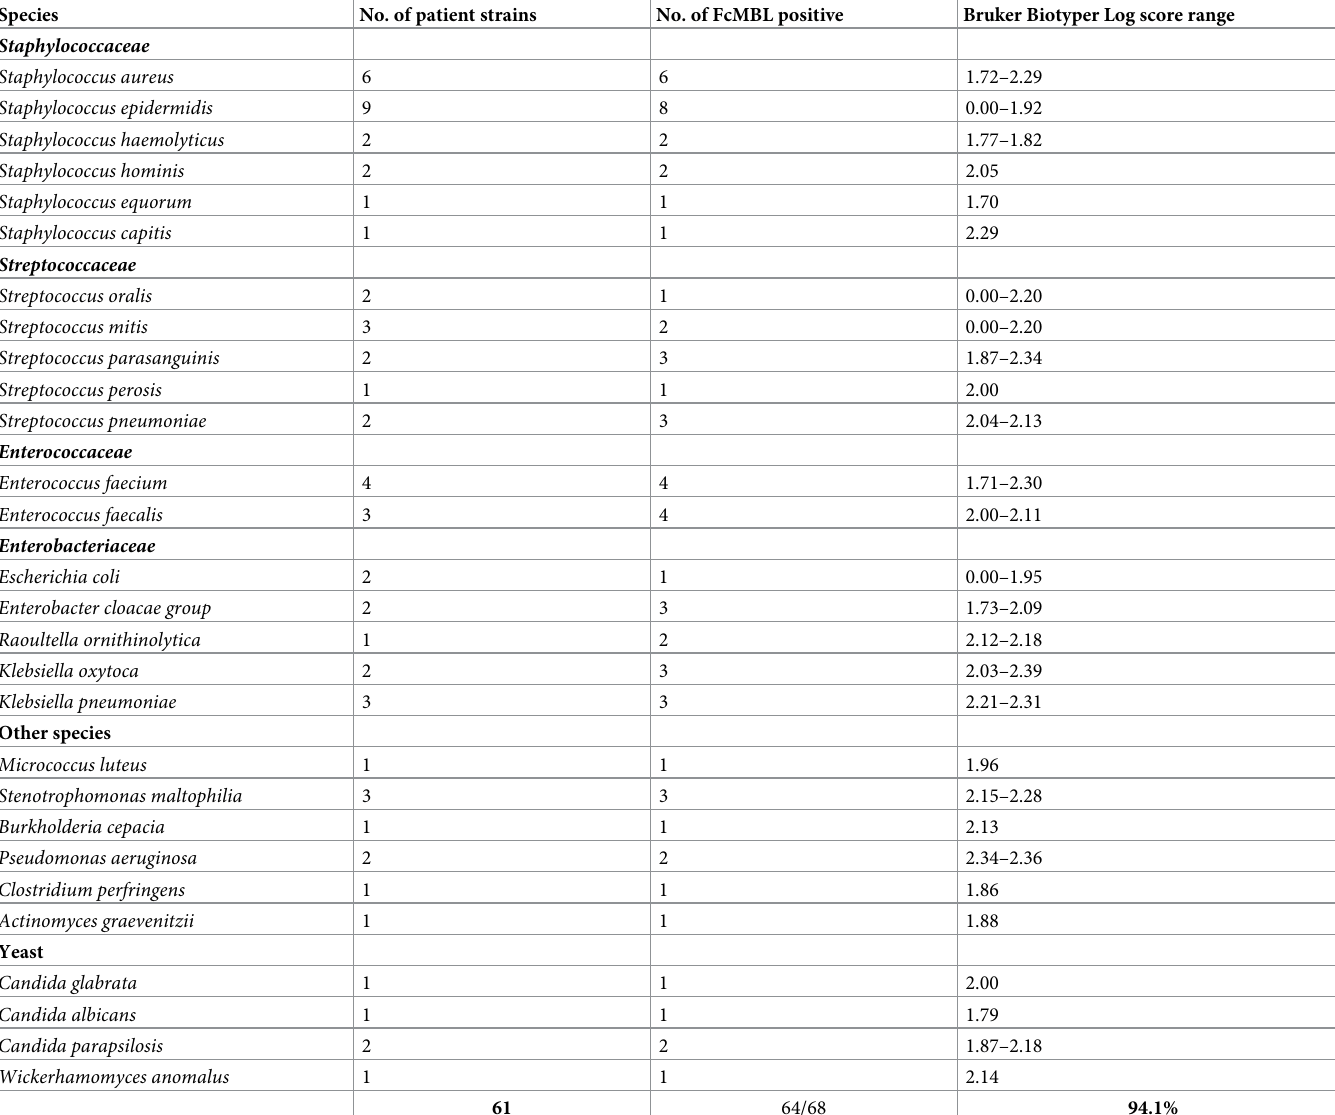
Table 1. MALDI-TOF MS identification of paediatric samples using FcMBL beads. Seven patients had both an anaerobic and aerobic bottle processed if available, accounting for the higher number of FcMBL positive samples seen for some